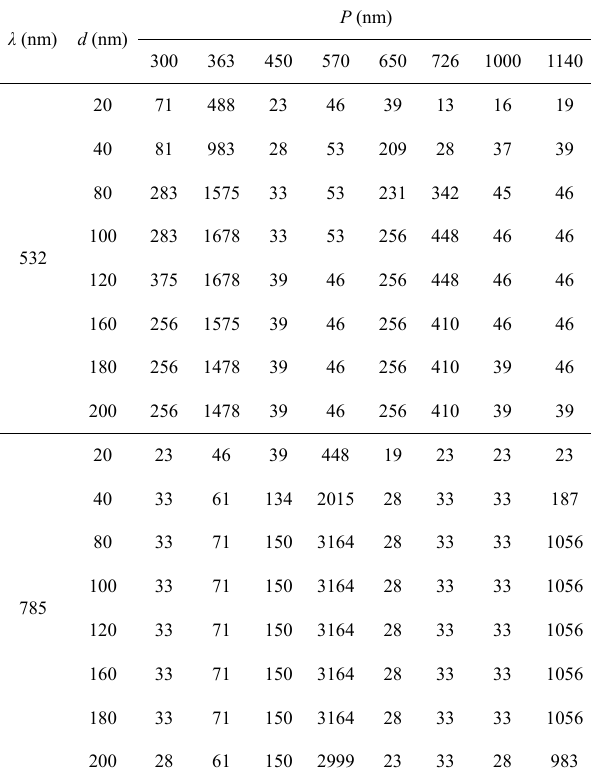
Table 1 EF at two excitation wavelengths as a function of the Ag layer thickness and grating